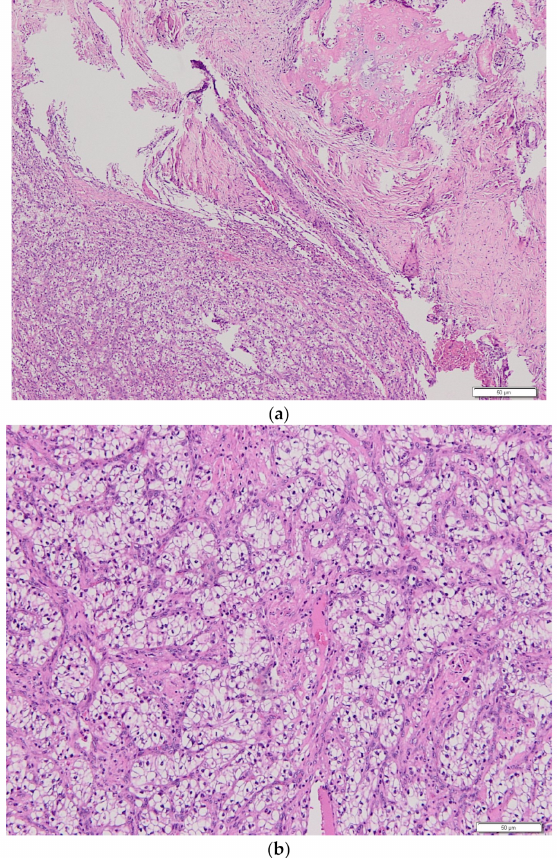
Figure 2. ( a ) Histopathological examination. A metastatic lesion of clear cell carcinoma to the humerus. ( b ) Histopathological examination. A metastatic lesion of clear cell carcinoma to the humerus in detail.